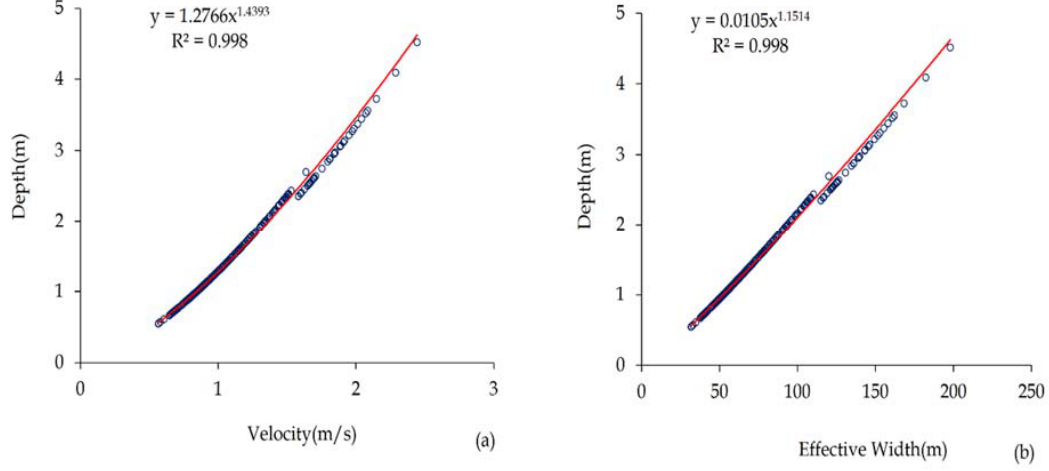
Figure 6. Time series of average depth calculated using Equation (4) and average velocity calculated using Equation (5) at Lhasa gauge from 1988 to 2018.